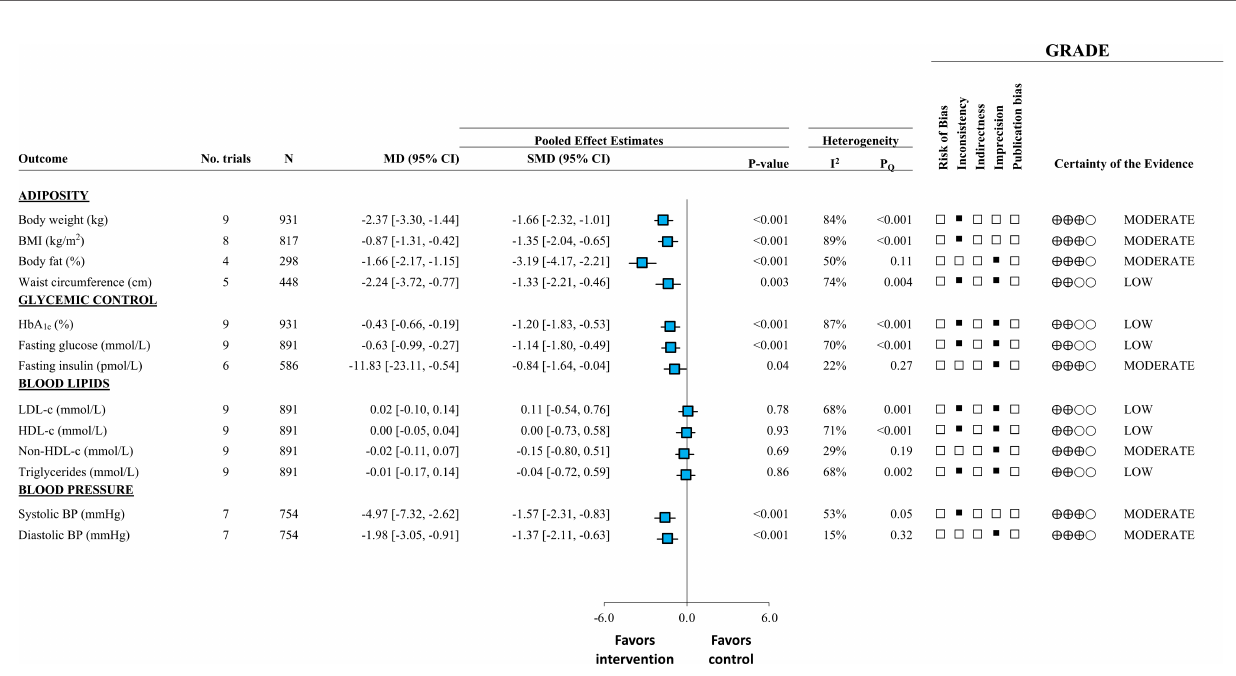
FIGURE 1 | Adapted from Noronha et al., 2019 (21). Summary of pooled effect estimates with GRADE assessments of randomized controlled trials investigating the effect of liquid meal replacements as part of a weight loss diet (intervention) compared with traditional low-calorie diets (control) on cardiometabolic risk factors. Estimates are expressed as mean differences (MDs) with 95% CIs and standardized MDs (SMDs) with 95% for visualization purposes. SMDs are represented by the blue square and 95% CIs by the line through the blue